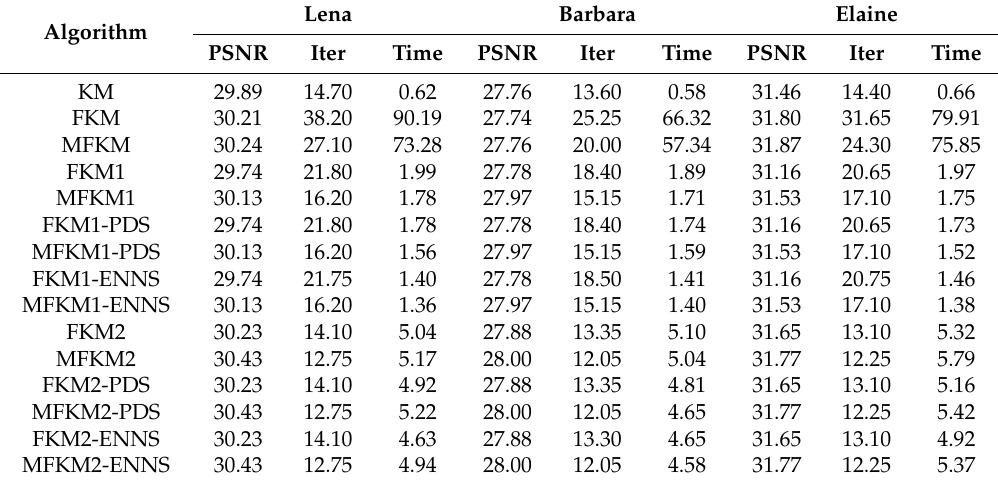
Table 8. PSNR (in dB), number of iterations and codebook design time (in seconds) for images Lena, Barbara and Elaine, using N = 256.